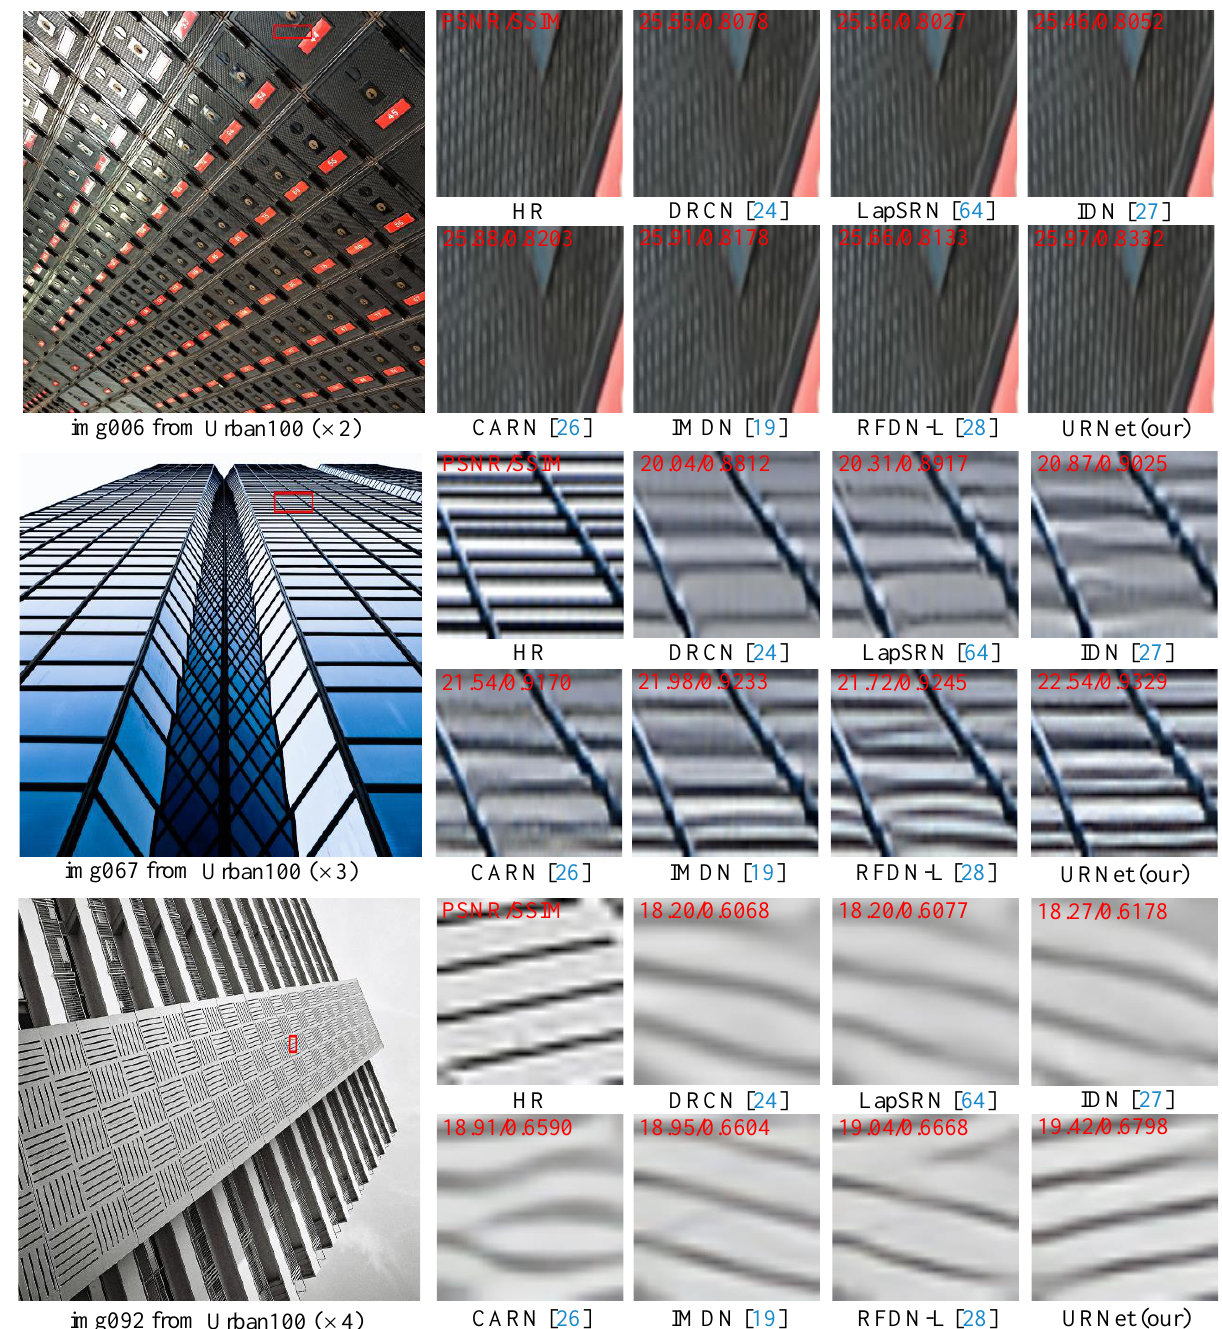
Figure 8. Visual qualitative comparisons of the state-of-the-art lightweight methods and our URNet on Urban100 dataset for × 2, × 3, and × 4 SR. Zoom in for best